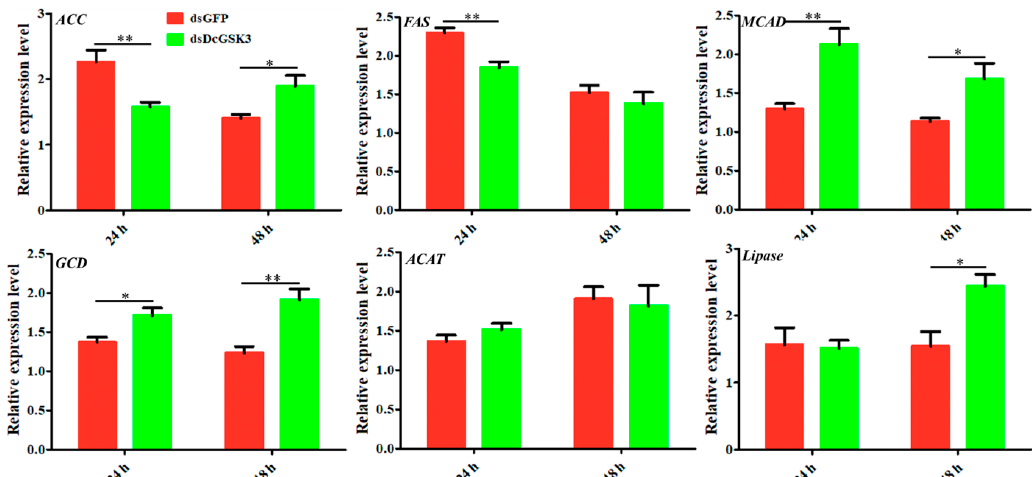
Figure 8. Effects of silencing DcGSK3 on expression levels of six genes related to fatty acid metabolism in D. citri . The ds GFP treatment group was used as a control. The mean expression level represents three biological replicates. The asterisks indicate significance differences by * ( p < 0.05) and ** ( p < 0.01).